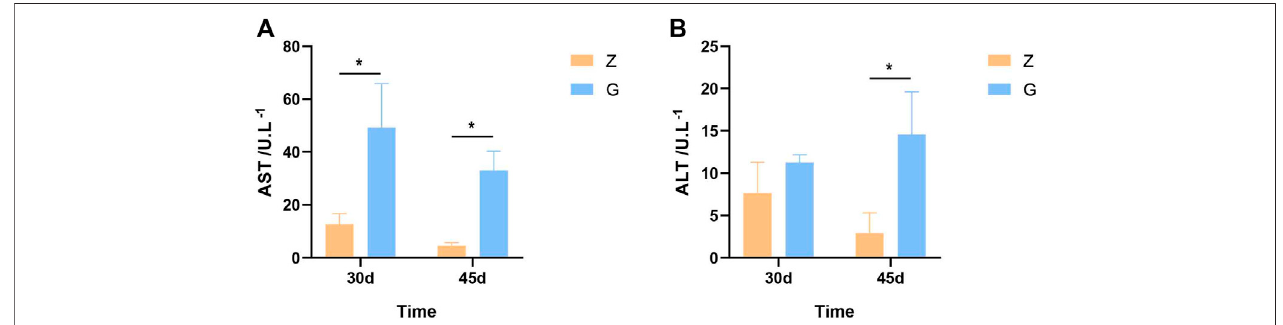
FIGURE 1 | Liver damage markers in largemouth bass. (A,B) AST and ALT after 30 and 45 days, respectively (* p <